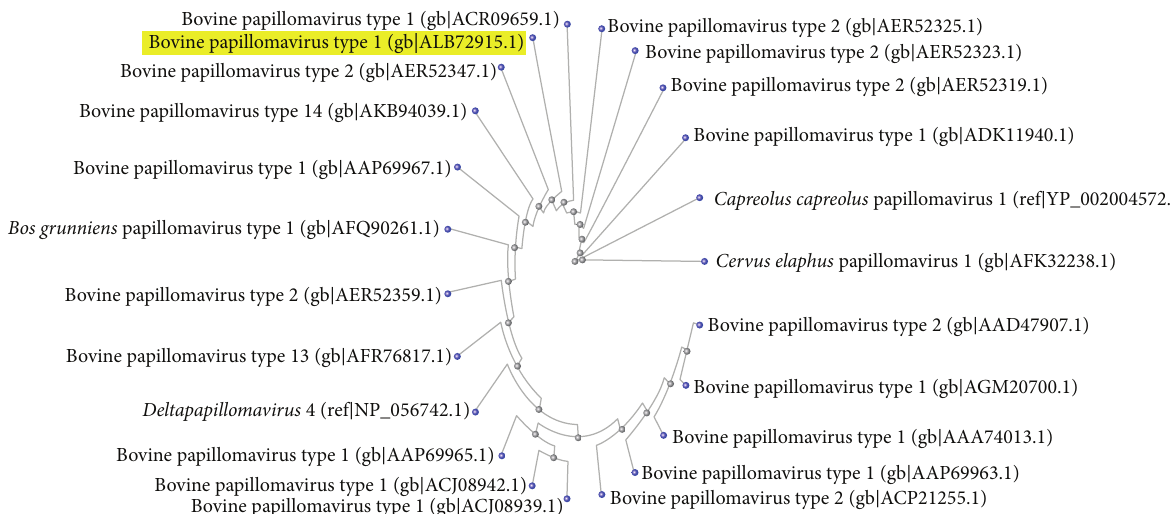
Figure 4: Distance tree created using the NCBI database after searching for Iraqi BPV-1 transforming protein E5. A 100% identity match was found with a BPV-1 E5 protein sequence isolated from a South African sarcoid-affected zebra (accession number ACR09659) and a 98% identity match was found with a BPV-1 E5 protein sequence isolated from an equine sarcoid in the United Kingdom (accession number AAP69967). The tree was created using the neighbor-joining